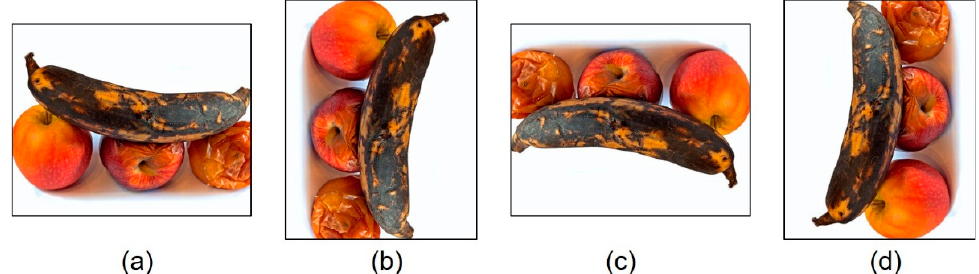
Figure 2. Image data augmentation using geometric transformations: ( a ) original image, ( b ) 90 ◦ rotation, ( c ) 180 ◦ rotation, ( d ) 270 ◦ rotation.